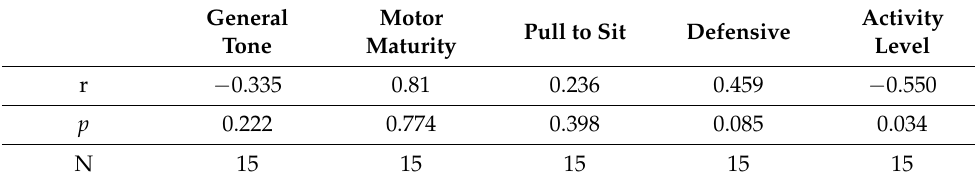
Table 3. The relationship between the NBAS Motor System cluster and